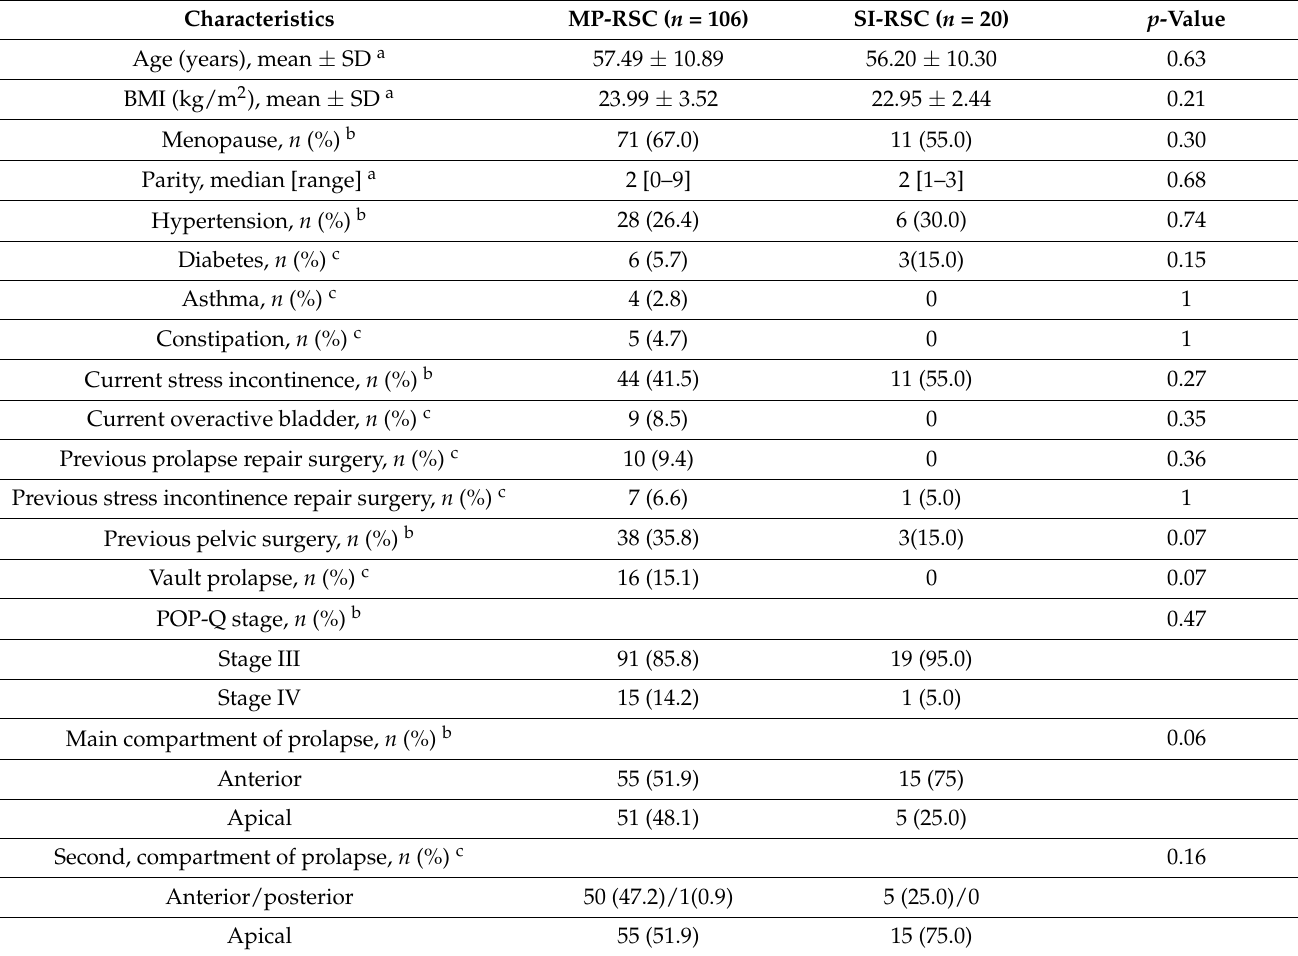
Table 1. Sociodemographic data and clinical history of